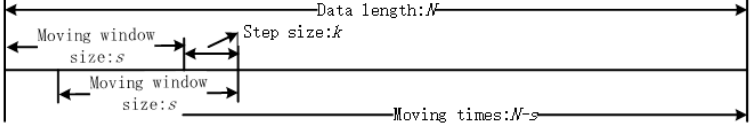
Figure 1. The workflow of the overlap moving window (OWM) algorithm.